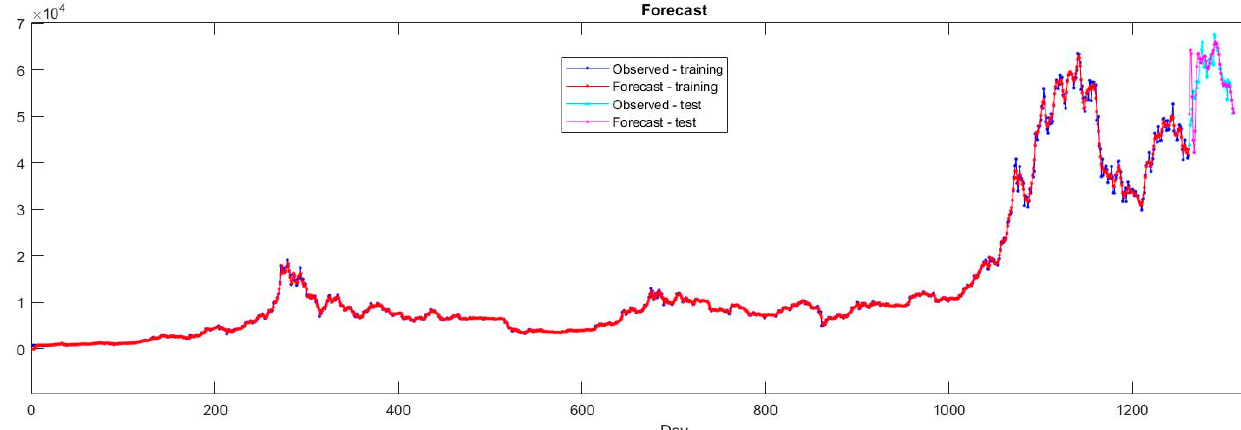
Figure 12. BTC–USD: LSTM–ADAM optimizer training.